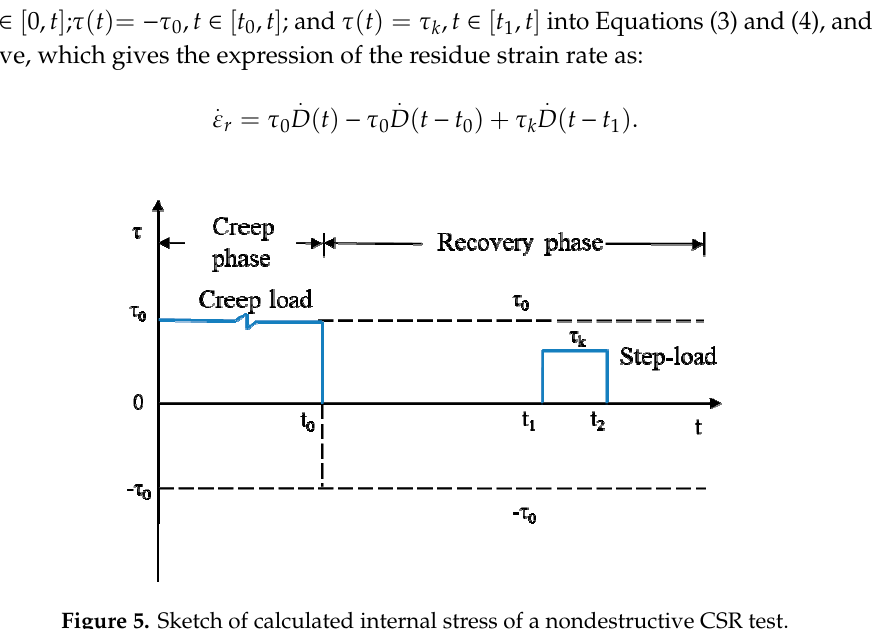
Figure 5. Sketch of calculated internal stress of a nondestructive CSR test.